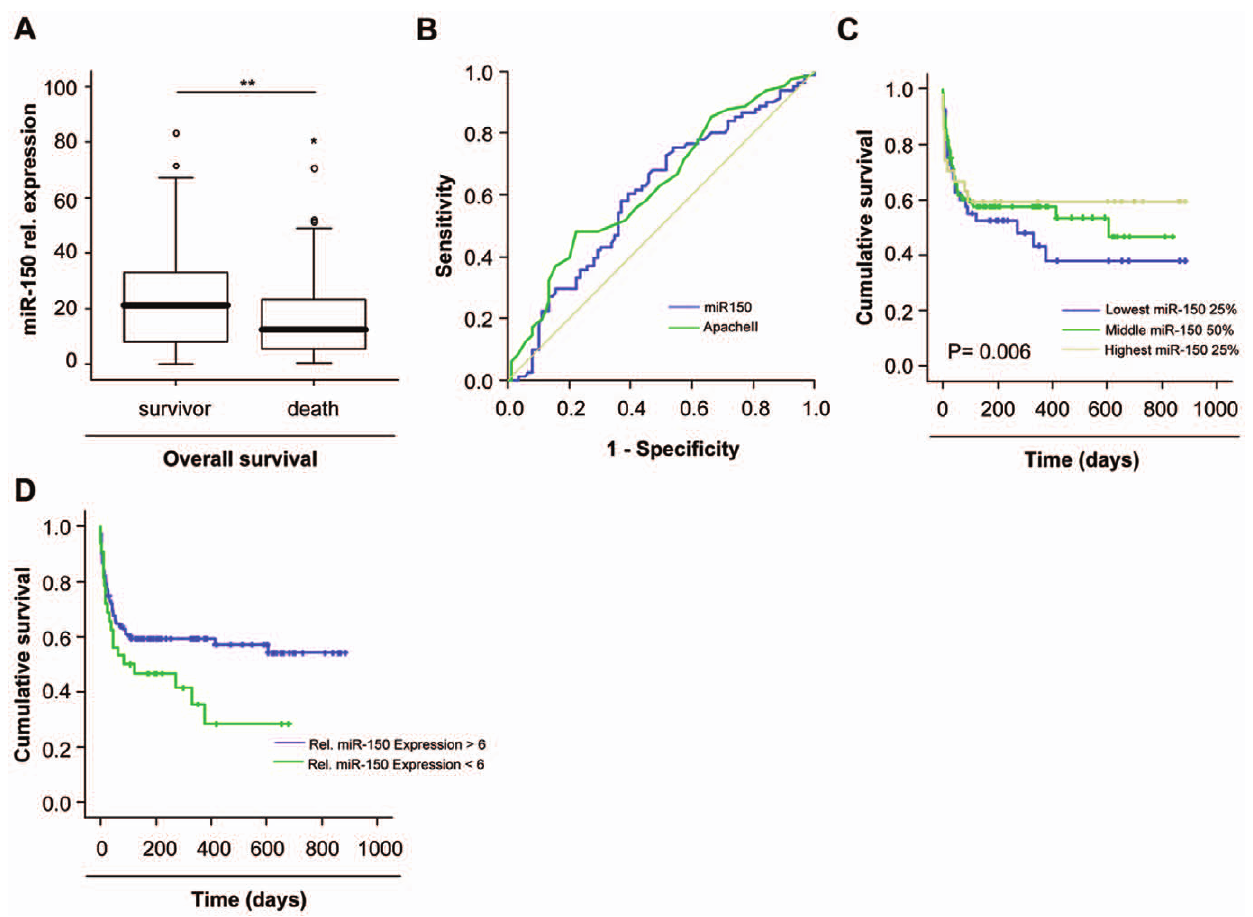
Figure 5. Low miR-150 serum concentrations are associated with an impaired prognosis of critically ill patients. (A) Long-term surviving patients had higher serum miR-150 levels on admittance to ICU (P=0.009, U-test) compared to patients that died during long term follow up which displayed significantly lower miR-150 levels. Box plot are displayed, where the bold line indicates the median per group, the box represents 50% of the values, and horizontal lines show minimum and maximum values of the calculated non-outlier values. (B) ROC curve analyses revealed a high prognostic accuracy of miR-150 for overall survival compared to the APACHE-II-score. (C) Kaplan-Meier curve analysis of ICU patients revealing that patients with miR-150 concentrations within the lower quartile had an increased overall mortality as compared to patients with miR-150 serum concentrations of highest quartile. P-values for the Cox regression analysis are given in the figure. (D) Kaplan-Meier survival curves of ICU patients showed that patients with low miR-150 concentrations had an increased overall mortality in the long-term follow-up compared to patients with higher miR-150 levels. ** P , 0.01.